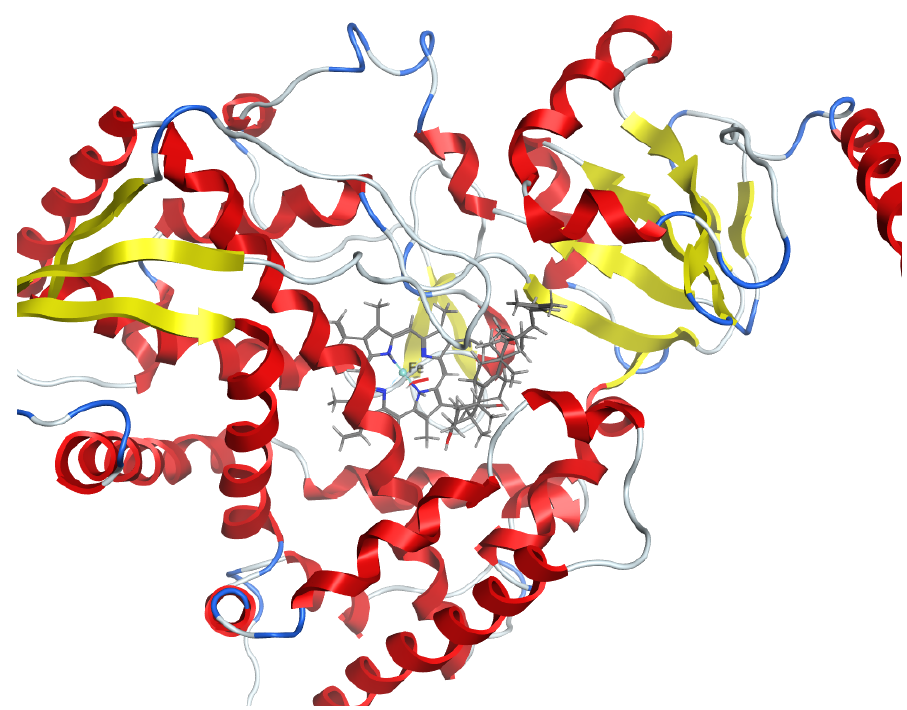
Figure 7. Three-dimensional structure of C. auris 14- α -demethylase enzyme bound with heme and lanosterol.